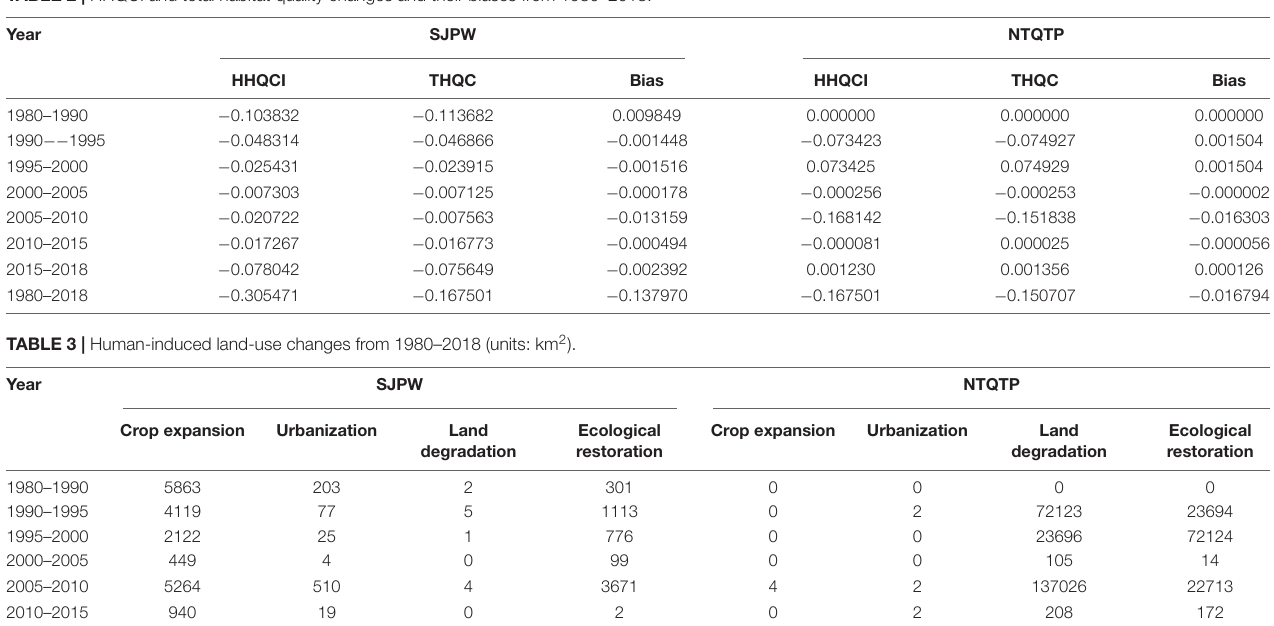
TABLE 2 | HHQCI and total habitat quality changes and their biases from 1980–2018.